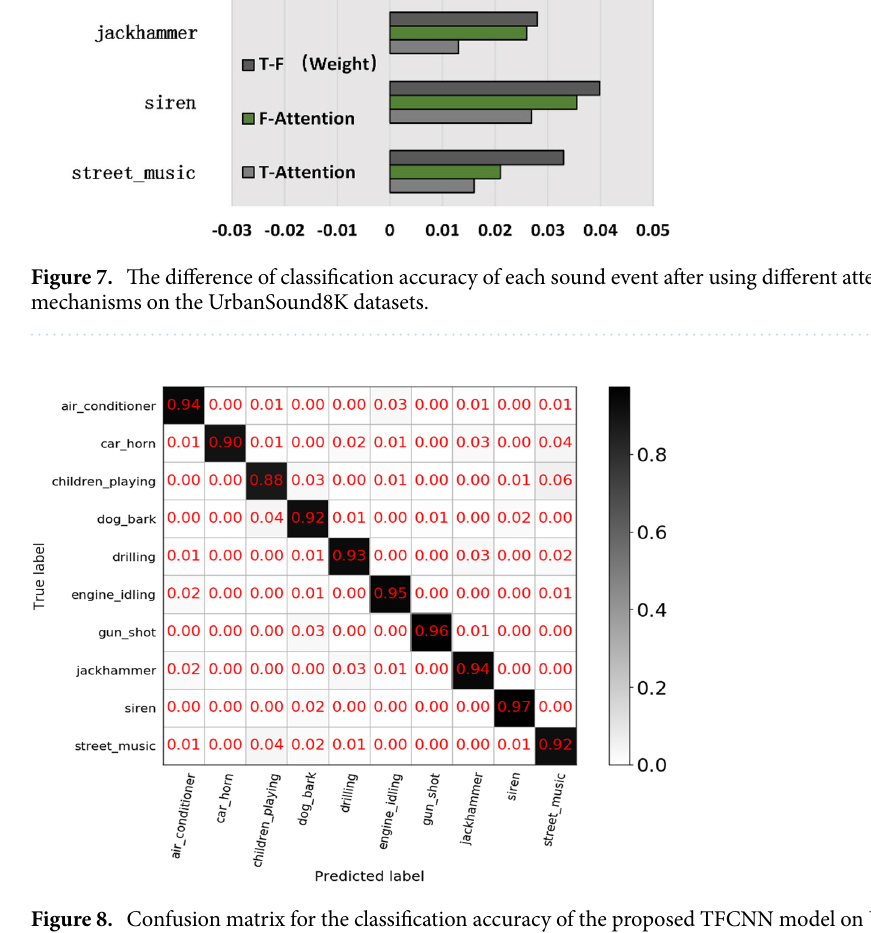
Figure 8. Confusion matrix for the classification accuracy of the proposed TFCNN model on UrbanSound8K